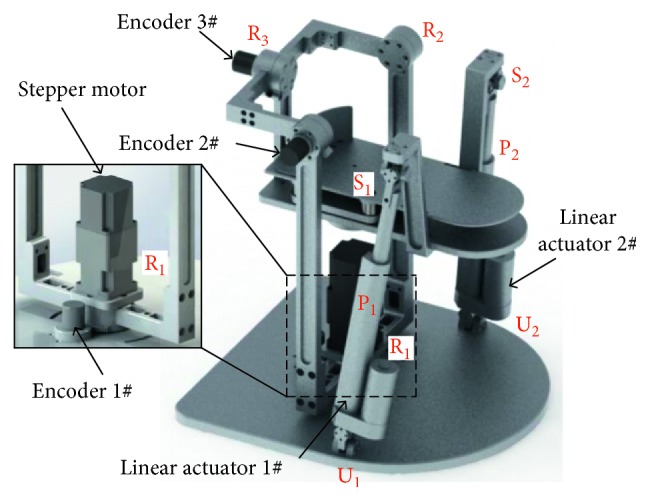
Structure of PARR.